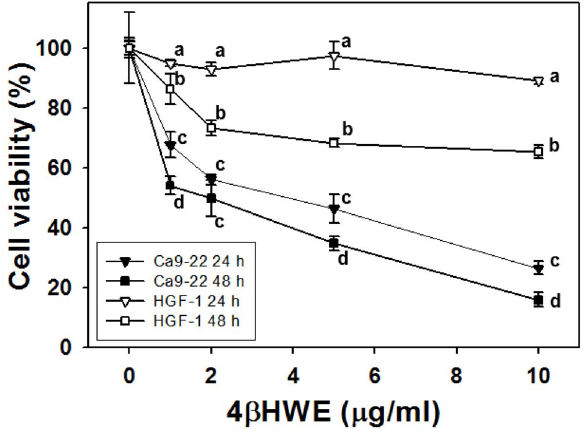
Figure 1. Treatment with 4 b HWE induced different cell viabilities in oral cancer Ca9-22 cells and in normal oral HGF- 1 cells. Cells were treated with 0, 1, 2, 5, and 10 m g/ml 4 b HWE for 24 and 48 h. Data, mean 6 SD (n=3). For the same drug concentrations in four different groups (Ca9-22 for 24 h, Ca9-22 for 48 h, HGF-1 for 24 h, HGF-1 for 48 h), data not connected by the same lower-case letter (upper-right corner of SD) significantly differed (one-way ANOVA with Tukey HSD Post Hoc